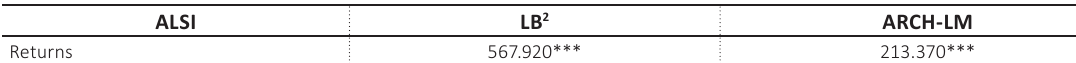
Table 2. Heteroscedasticity tests for the ALSI